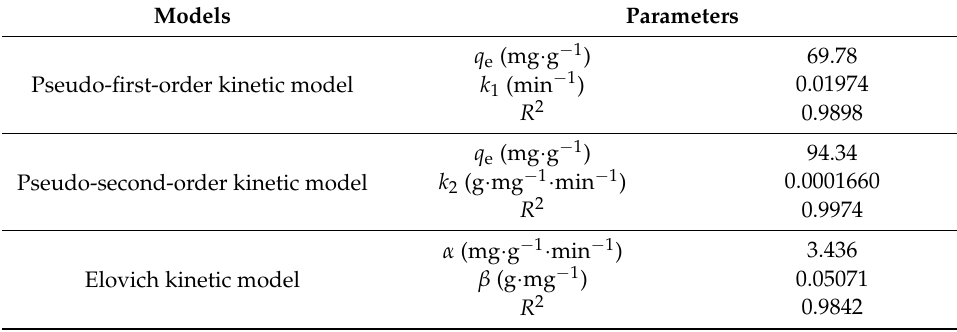
Table 1. Kinetic model parameters for the adsorption of Pb 2+